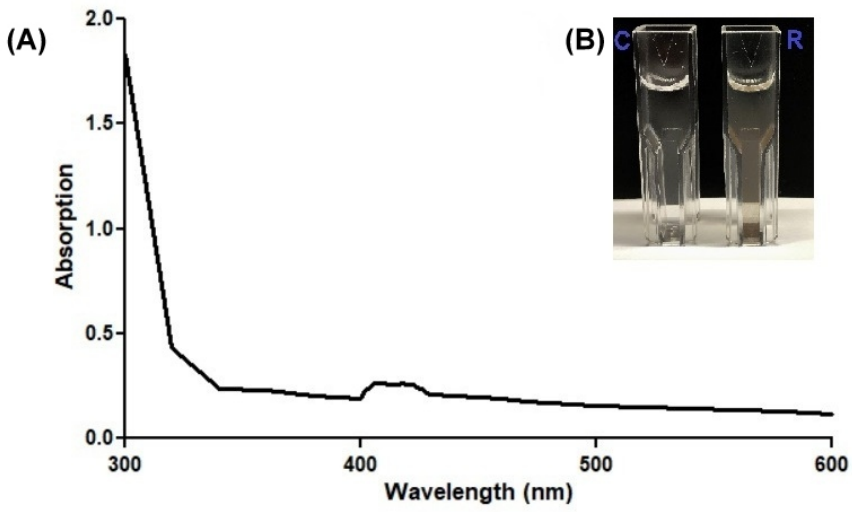
Figure 6. Spectrophotometric analysis of silver reduction without the use of a source of the nitrate reductase enzyme (2 mM AgNO 3 and 0.2 mM NADH, 48 h incubation at 55 °C temperature) ( A ), reductase enzyme (2 mM AgNO 3 and 0.2 mM NADH, 48 h incubation at 55 ◦ C temperature) ( A ), and and the color change ( B ). R—reaction mix; C—control. the color change ( B ). R—reaction mix;